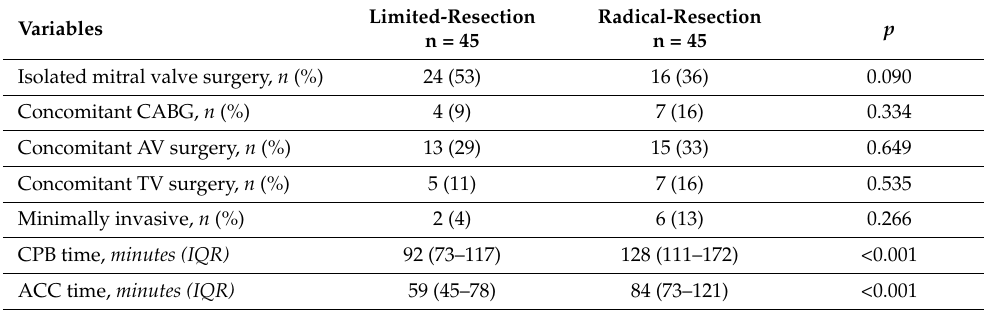
Table 3. Operative